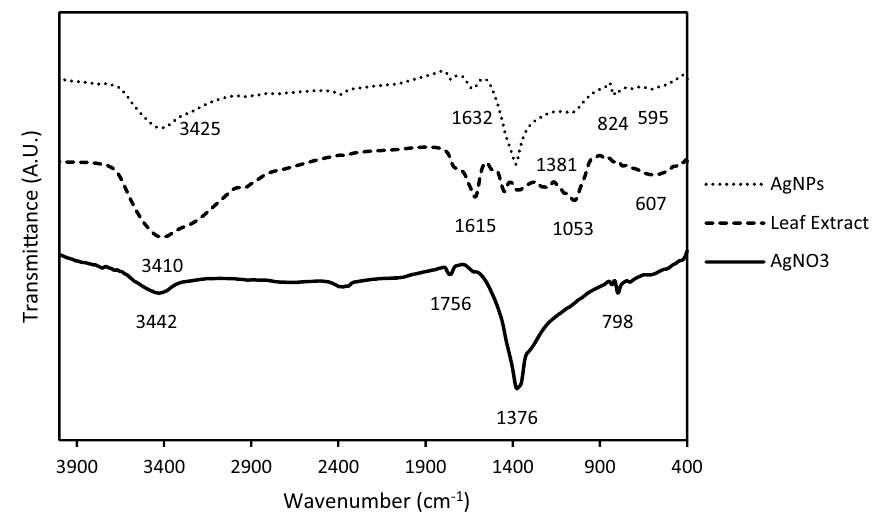
Figure 3. FTIR spectrum of the AgNO 3 solution, PGLE, and the resultant biosynthesized AgNPs.